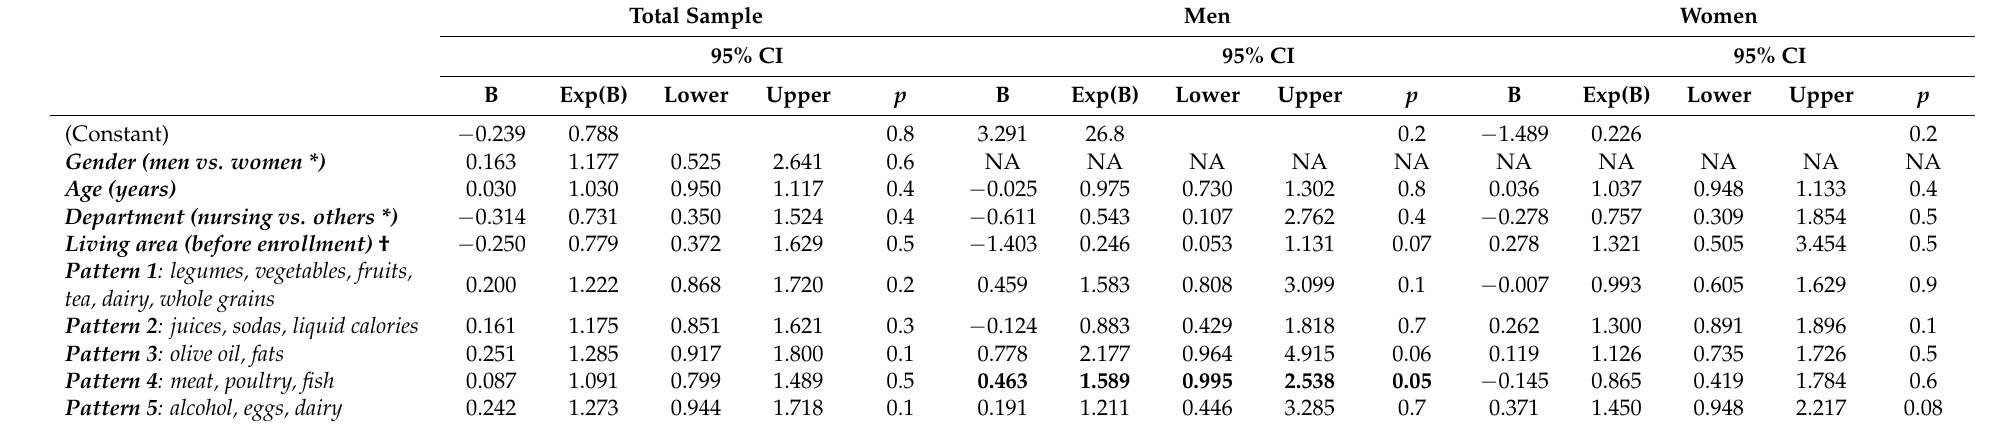
Table 4. Logistic regression analysis for overweight/obesity in the total sample, men and